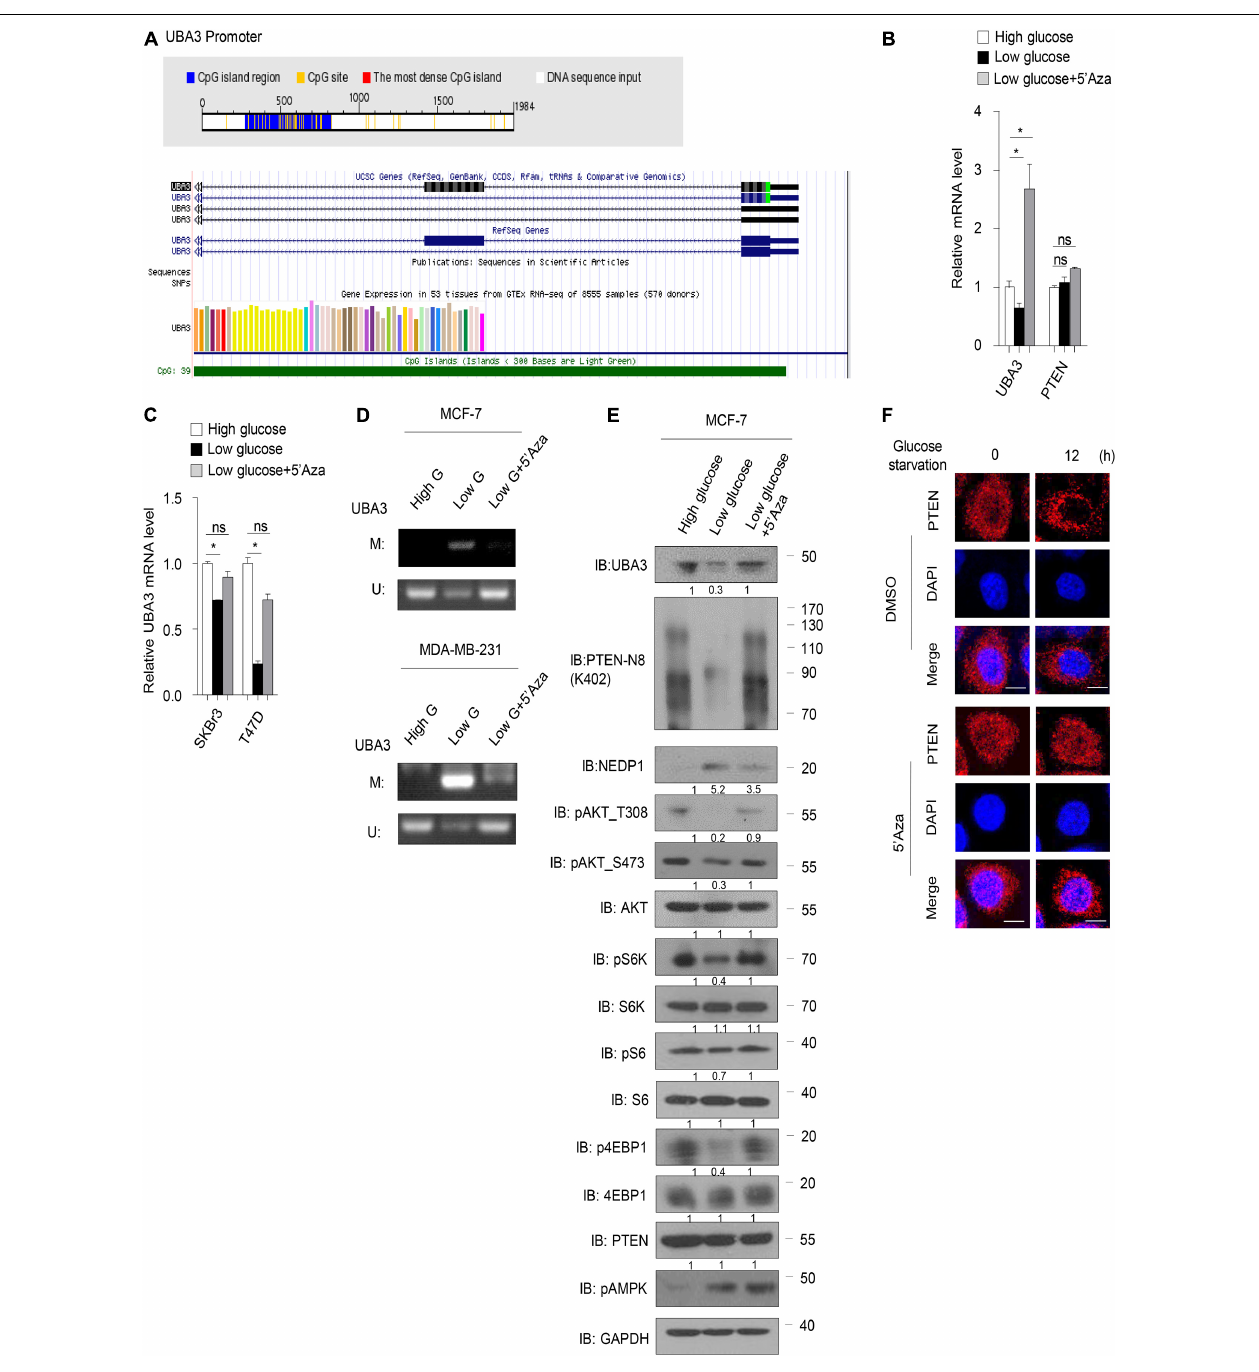
FIGURE 6 | High concentration of glucose inhibits UBA3 promoter methylation. (A) The CpG Island within the UBA3 gene promoter region (upstream 2000bp of the UBA3). Blue line depicts the CpG island region and the yellow vertical bars represent a CpG site. White line depicts the DNA sequence (Top). The green line indicates the CpG Island of UBA3 in UCSC database (Bottom). (B) UBA3, NEDP1, PTEN expression was analyzed by qPCR in MCF-7 cells (high glucose, 25 µ M; low glucose, 5 µ M), without or with 5-Aza-2’-deoxycytidine (5’Aza) treatment. Cells were treated with 5 mM 5’Aza for 72 h, and the medium was replaced with freshly added 5’Aza for every 24 h. Data are shown as the mean ± SD. * P < 0.05, ** P < 0.01, *** P < 0.001. (C) UBA3 mRNA level was analyzed by qPCR in breast cancer cell lines. Data are shown as the mean ± SD. * P < 0.05, ** P < 0.01, *** P < 0.001. (D) The methylation status of the UBA3 promoter in breast cancer cell lines medium containing different glucose concentrations, without or with 5’Aza treatment. The CpG islands of UBA3 were analyzed by methylation-specific PCR (MSP). U, unmethylated; M, methylated. (E) Immunoblot analysis of WCL from MCF-7 cells cultured in cell medium containing different glucose concentrations, without or with 5’Aza treatment. The quantifications of indicated protein contents were analyzed. (F) Immunofluorescence of PTEN in MCF-7 cells. Cells were deprived for glucose for different time. Cells were treated without or with 1 µ M 5’Aza for 12 h. Scale bar, 25 µ m.